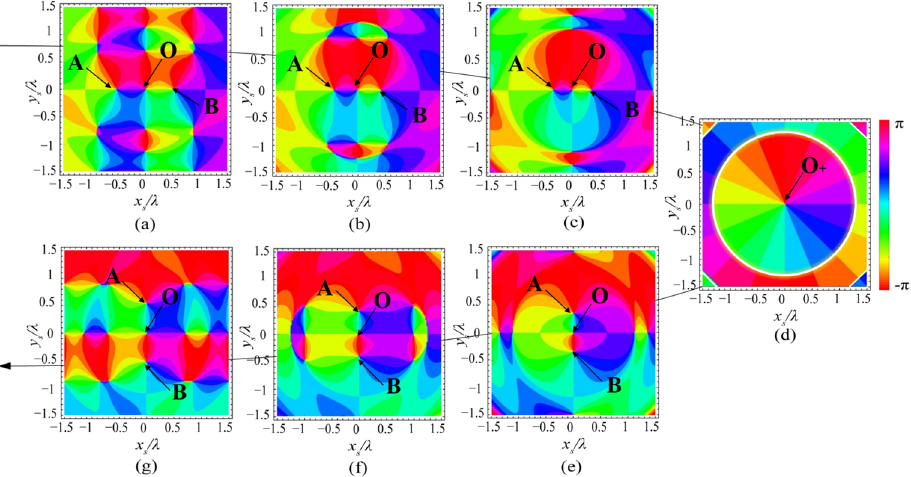
(cid:104) (cid:105) ( c ) p on the focal plane xy